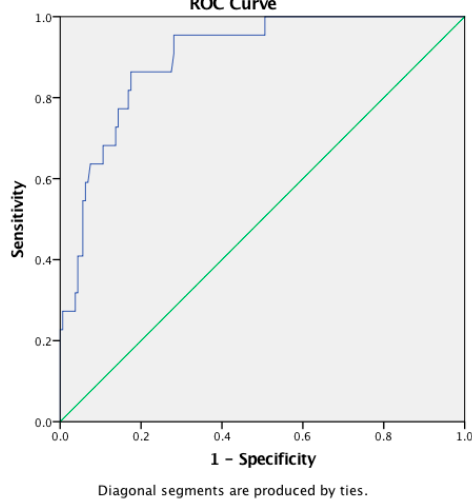
Figure 1. ROC curve of NLR.